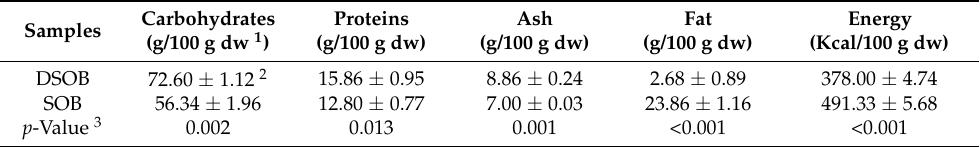
Table 5. Nutritional value and energetic value of defatted seeds of Oenothera biennis (DSOB) and seeds of Oenothera biennis (SOB).